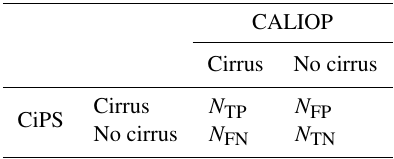
Table 1. Contingency table for the cirrus detection from CALIOP and